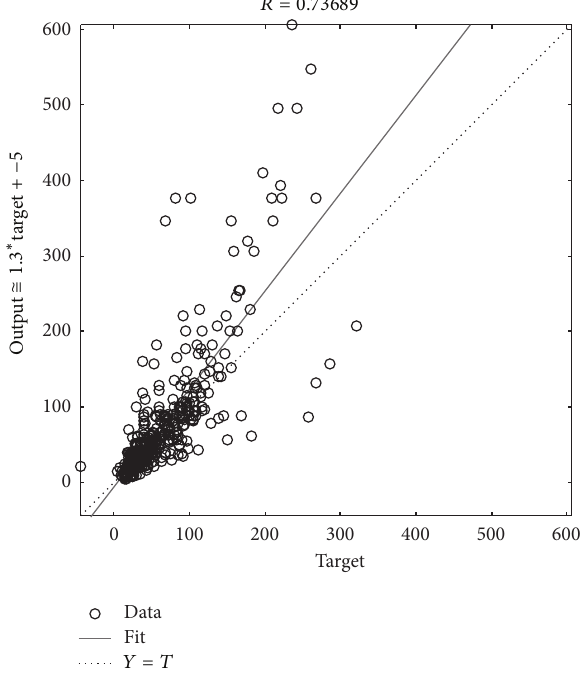
Figure 17: GP zinc expression after dropping